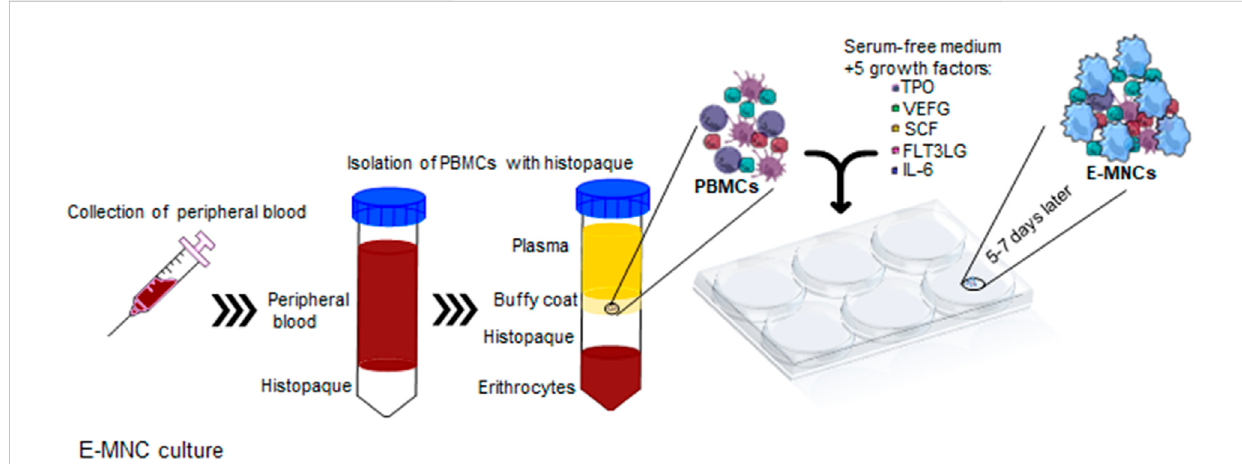
FIGURE 1 Schematic diagram describing 5G-culture. PBMNCs were isolated from buffy coat and cultured for 6 – 7 days in serum-free medium supplemented with fi ve recombinant proteins, TPO, VEGF, SCF, Flt-3 ligand, and IL-6. After cultivation, effective-mononuclear cells (E-MNCs) were